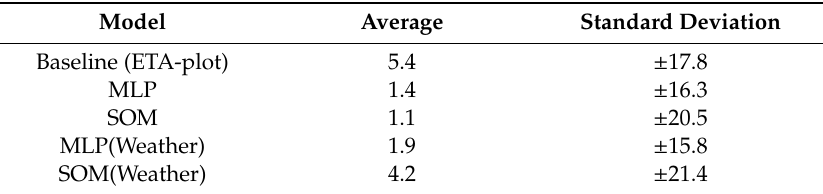
Table 6. Average over summed relative error per journey for each model.